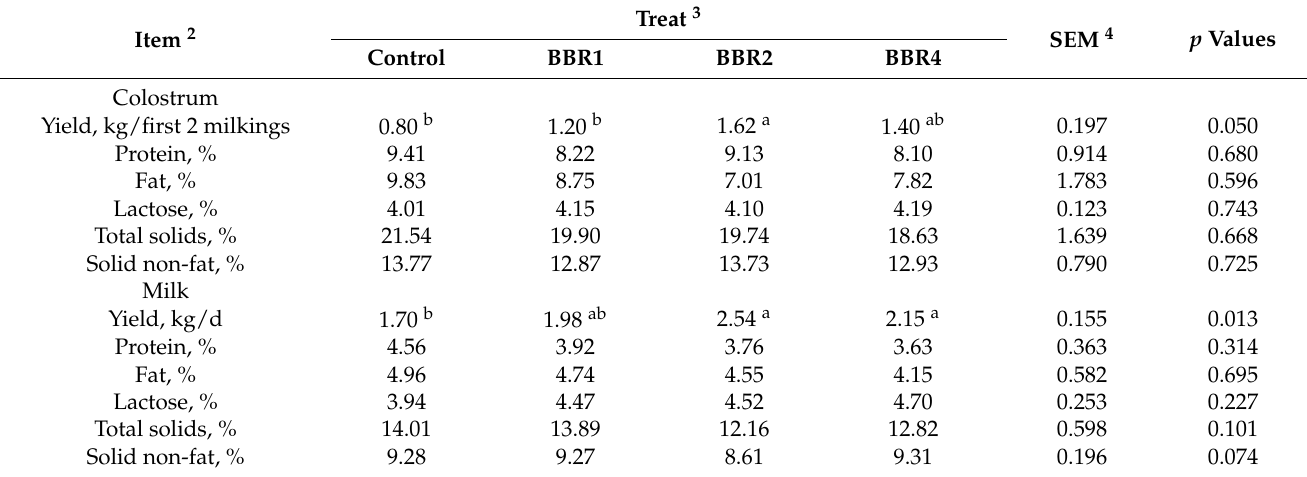
Table 4. Effect of Berberine (BBR) supplementation on colostrum and milk performance of dairy Saanen goats 1